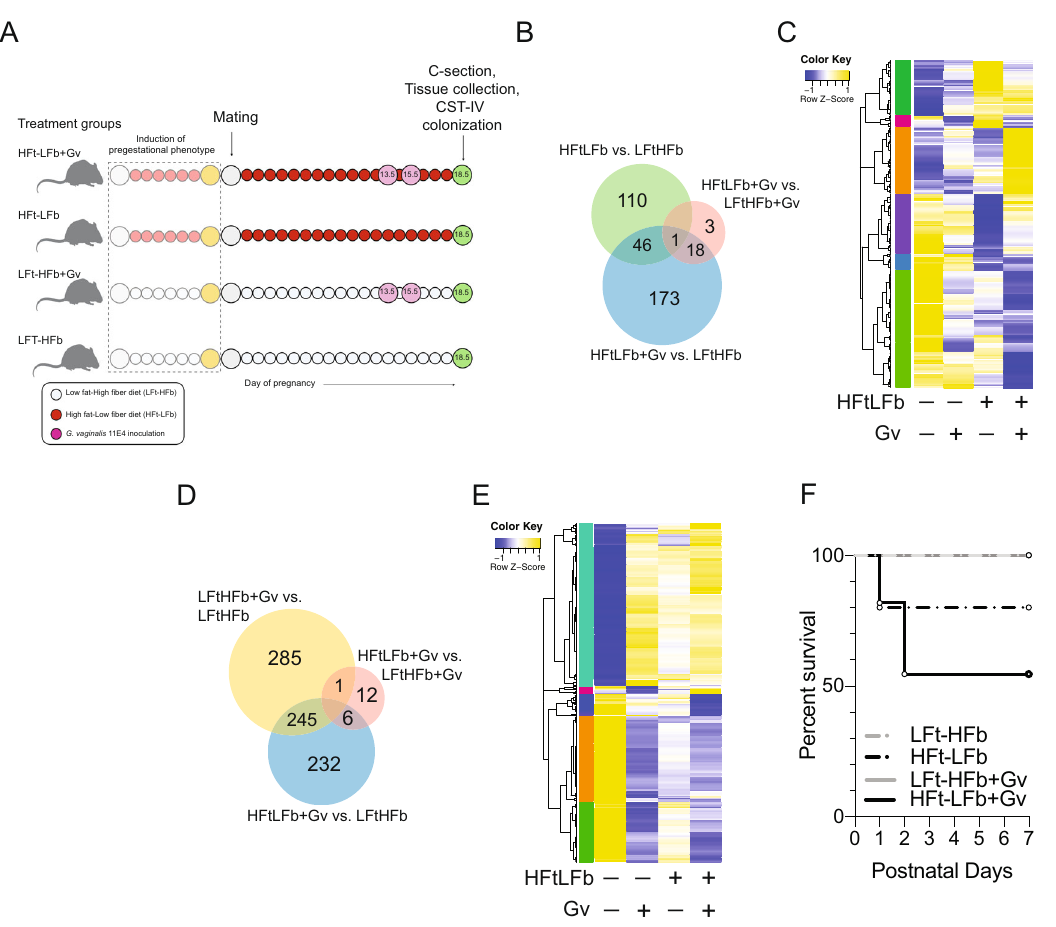
Fig. 4 Prenatal exposure to maternal diet-induced obesity and a nonoptimal vaginal microbiota alter the transcriptional landscape in the placenta and fetal ileum of male offspring. A Schematic of experimental design to determine whether compounding maternal adversities, such as diet and G. vaginalis vaginal colonization, impact fetal development that may contribute to increased offspring mortality risk. We induced the pregestational phenotype and dams were colonized with G. vaginalis 11E4 on gestational day 13.5 and 15.5. At gestational day 18.5, tissue from one cohort of male offspring was collected for analysis of gene expression patterns in the placenta and ileum. A second cohort of offspring were colonized with the nonoptimal CST IV human vaginal microbiota. Created with BioRender.com. B Venn diagram displaying the number of differentially expressed genes in the embryonic day 18.5 placenta of male offspring exposed to a maternal high-fat low- fi ber diet, G. vaginalis 11E4 vaginal colonization, or a combination (linear fi t model, FDR < 0.1, log(FC) = 1.5; n = 351 genes). LFt-HFb = low-fat high- fi ber; HFt-LFb = high-fat low- fi ber; Gv = G. vaginalis 11E4. C Heatmap depicting mean expression of genes in the placenta of embryonic day 18.5 male offspring exposed to a maternal high-fat low- fi ber diet, G. vaginalis 11E4 vaginal colonization, or a combination (HFt-LFb + Gv) (linear fi t model, FDR < 0.1, log(FC) = 1.5). These comparisons reveal a unique cluster of genes that are differentially expressed in HFt-LFb + Gv male placenta compared with other treatment groups. Z -scores plotted across individuals for each gene. LFt-HFb = low-fat high- fi ber; HFt- LFb = high-fat low- fi ber; Gv = G. vaginalis 11E4. Color based on row Z -scores for each gene. Six clusters of differentially regulated genes in each treatment group are indicated. N = 3 males per treatment. D Venn diagram displaying the number of differentially expressed genes in the embryonic day 18.5 ileum of male offspring exposed to a maternal high-fat low- fi ber diet, G. vaginalis 11E4 vaginal colonization, or a combination (HFt-LFb + Gv) These comparisons reveal a unique cluster of genes that are differentially expressed in the fetal ileum of HFt-LFb + Gv males compared with other treatment groups (linear fi t model, FDR < 0.1, log(FC) = 1.5; n = 781 genes). LFt-HFb = low-fat high- fi ber; HFt-LFb = high-fat low- fi ber; Gv = G. vaginalis 11E4. E Heatmap depicting mean expression of genes in the ileum of embryonic day 18.5 male offspring exposed to a maternal high-fat low- fi ber diet, G. vaginalis 11E4 vaginal colonization, or a combination (linear fi t model, FDR < 0.1, log(FC) = 1.5). Color based on row Z -scores for each gene. Five clusters of differentially regulated genes in each treatment group are indicated. N = 3 males per treatment. F Survival of offspring from dams that experience a single or multiple compounding adversities in a second validation cohort. All pups were C-section delivered and gavaged with human CST IV inoculant, showing the highest offspring mortality risk in HFt-LFb + Gv male offspring exposed to CST IV at birth. LFt-HFb = low-fat high- fi ber; HFt-LFb = high-fat low- fi ber; Gv = G. vaginalis 11E4. Kaplan – Meier survival analysis. N = 24 – 40 offspring per treatment male placenta compared with LFt-HFb male placenta, with the expressed between HFt-LFb + Gv and LFt-HFb male placenta. majority of these genes downregulated in HFt-LFb relative to LFt- Functional enrichment of these differentially expressed genes HFb male placentas (Fig. 4B,C). Functional enrichment of these showed enrichment for pathways involved in collagen degrada- HFt-LFb-speci fi c downregulated genes demonstrated enrichment tion, response to in fl ammation, and receptor-mediated endocy- in pathways involved in the response to changing nutrient levels, tosis (Supplementary Fig. 13a). fatty acid metabolism, dopamine transport, and serotonin Geneset enrichment analysis (GSEA) was next used to identify transport. Additionally, 173 of 351 genes were differentially pathways that were altered by G. vaginalis 11E4 vaginal